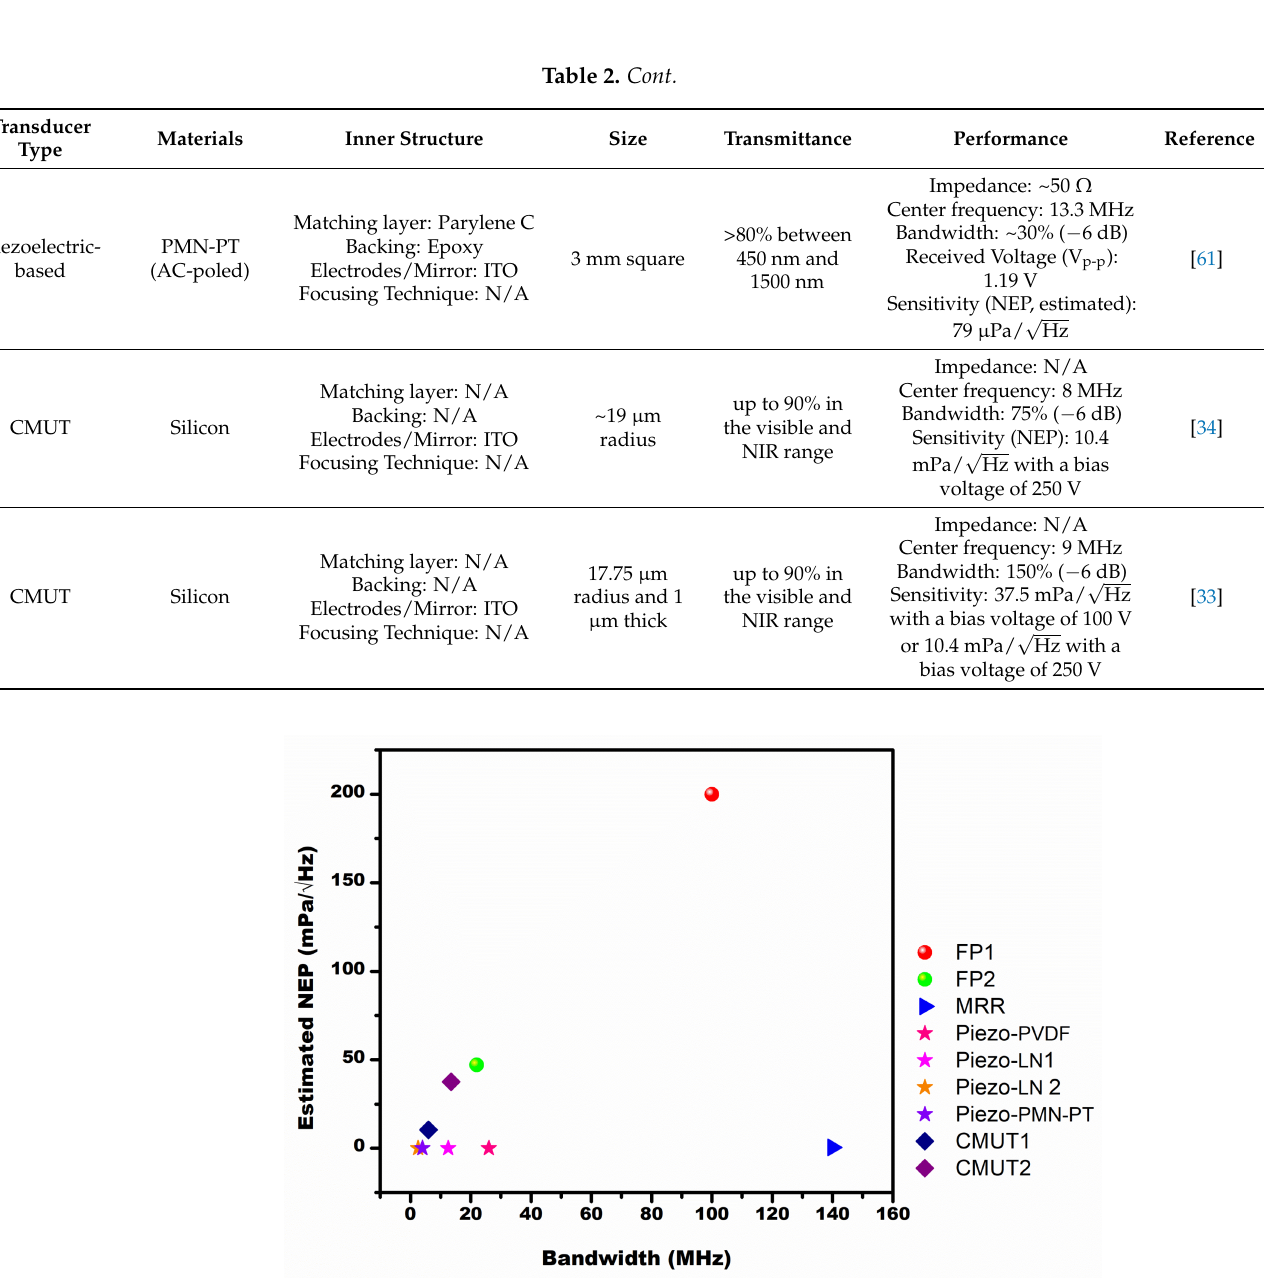
Figure 5. Estimated sensitivity of transparent US sensors and their bandwidth. FP1 [40], FP2 [42], MRR [22], Piezo-PVDF [26], Piezo-LN1 [31], Piezo-LN2 [60], Piezo-PMN-PT [61], CMUT1 [34], CMUT2